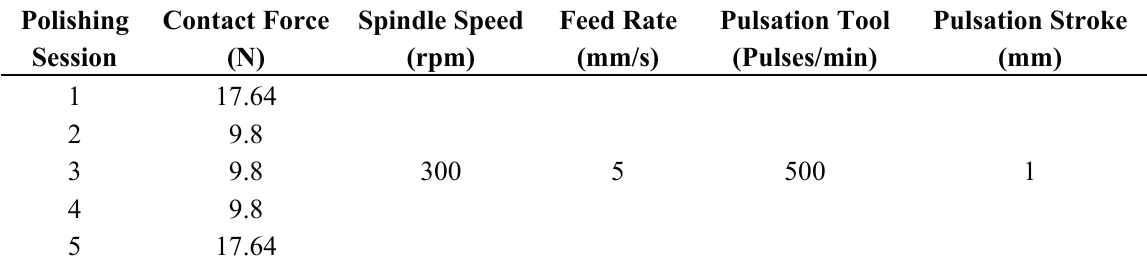
Table 1. Polishing conditions at the five sessions